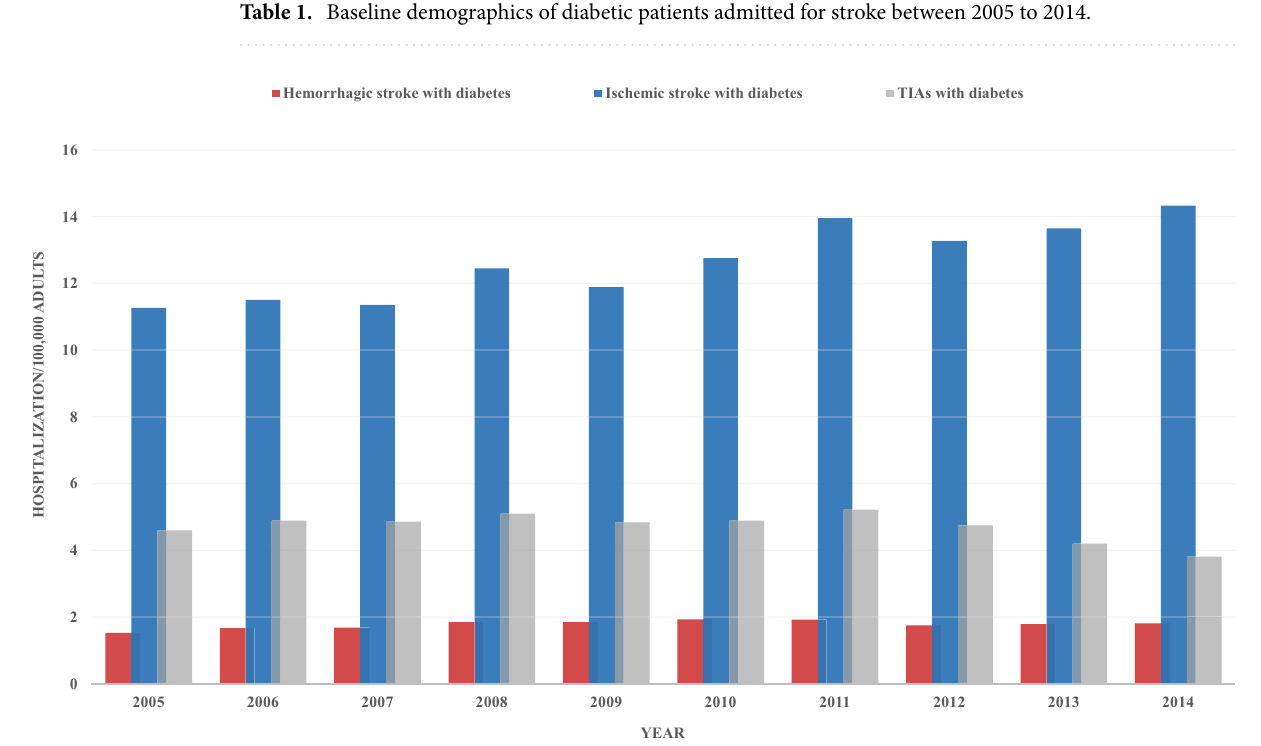
Figure 2. Trends in hospitalizations per 100,000 US adults for incident